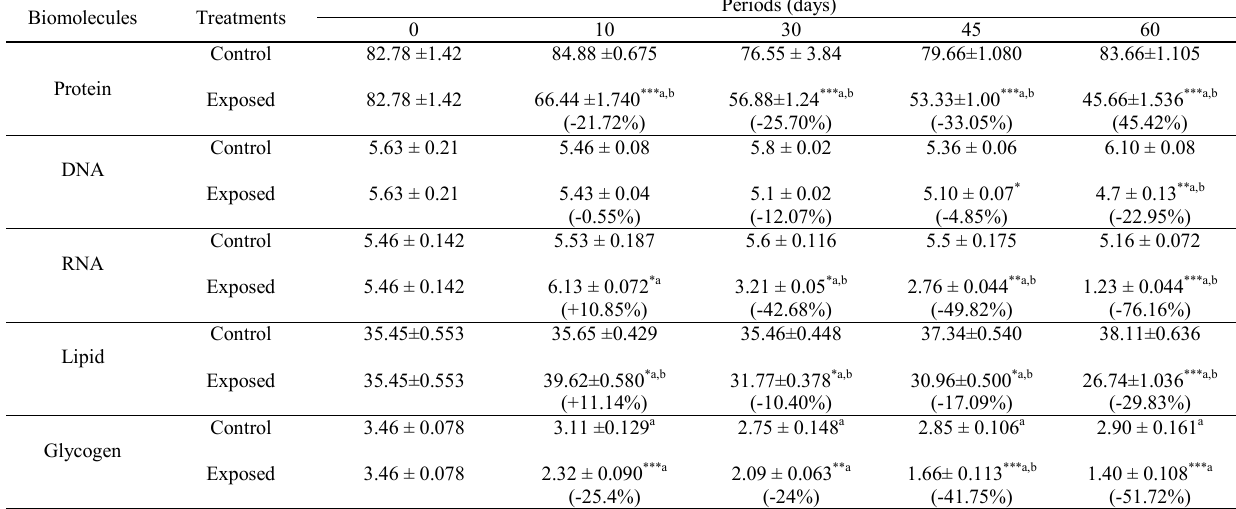
Table 5. Fluctuations in different biomolecules in the muscles of Clarias batrachus at different period of exposure to 1 mg/L of sodium arsenite. Protein, DNA, RNA, lipid, and glycogen were expressed in mg/gm wet wt of tissue. Data are shown as mean ± SEM (n = 9). (%) Denote changes over respective controls. Two way ANOVA followed by Dunnett’s t -test. The criterion for significance differences set at ( * ) p <0.05, ( ** ) p <0.01 and ( *** ) p <0.001 with respective control. ( a ) Indicates when exposed groups were compared with 0 day controls and ( b ), when exposed groups were compared with previous exposed